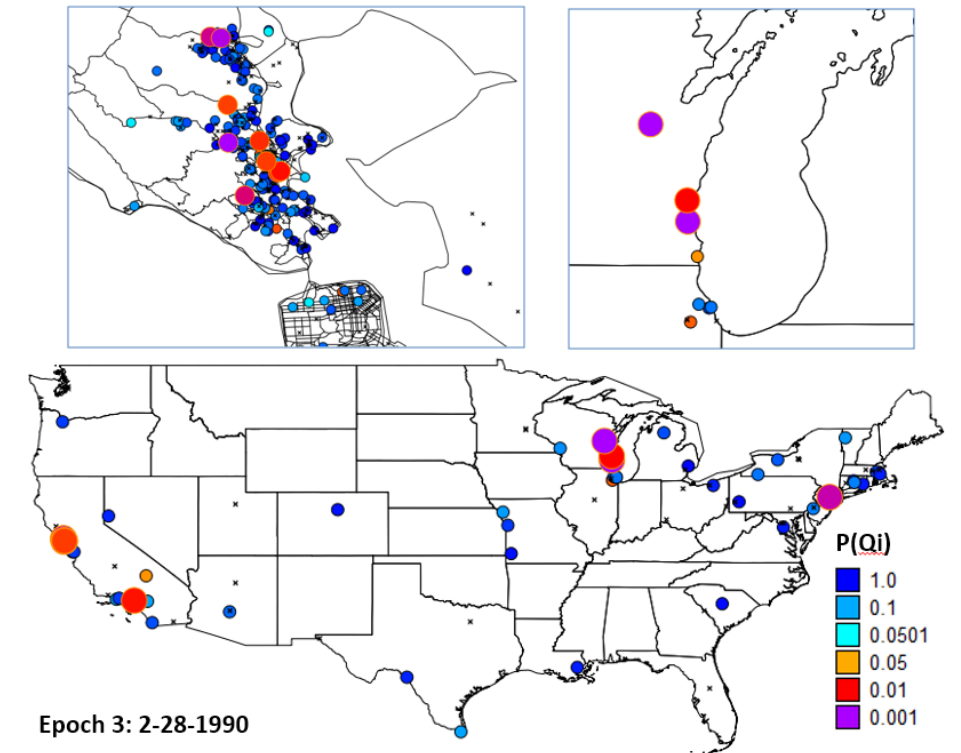
Figure 8. Locations of cases with significant clustering over their life course at the end of Epoch 3. At that time 9 cases with significant clustering resided in Marin County ( upper left ), with other clusters found in the upper Midwest ( upper right ), southern California and Long Island ( bottom